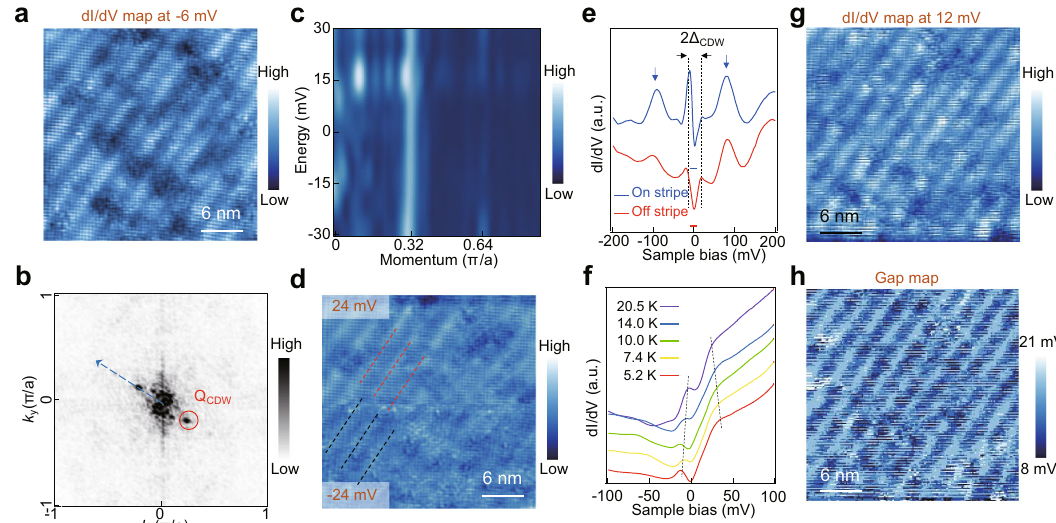
Fig. 2 Charge density wave on the (001) surface of CoSi. a d I /d V map of a surface region with the stripe modulation taken under − 6 mV. b 2D Brillouin zone of the surface withdrawn from the FT image of ( a ). The CDW spot is outlined by a red circle. c Normalized intensity pro fi les of the FT images along the blue dashed arrow in ( b ) under bias voltages from − 30 mV to 30 mV. The intensity peaks around Q CDW under different energies. The CDW wave vector is nondispersive with energy. d d I /d V maps of the region in ( a ) taken at 24 mV (upper panel) and − 24 mV (lower panel). The bright stripes of the upper (lower) are outlined by red (black) dashed lines. e Typical d I /d V curves taken on (blue) and off (red) the bright stripes in Fig. 1b. Zero conductance for each spectrum is marked with a solid horizontal line. The blue arrows indicate two broad peaks in the spectra. The CDW gap 2 Δ CDW is determined by the energy spacing between the left and right coherence peaks. f Temperature dependence of the CDW gap. The d I /d V sepctra are taken at a region different from that in Fig. 1b. Each curve is averaged from 10 independent d I /d V spectrum on the same bright stripe under different temperatures. The gap size gradually decreases with increasing temperature. g dI/dV map at 12 mV. h Gap map of the region in ( g ) acquired by recording the gap sizes at each pixel, showing a modulation of gap size by the CDW